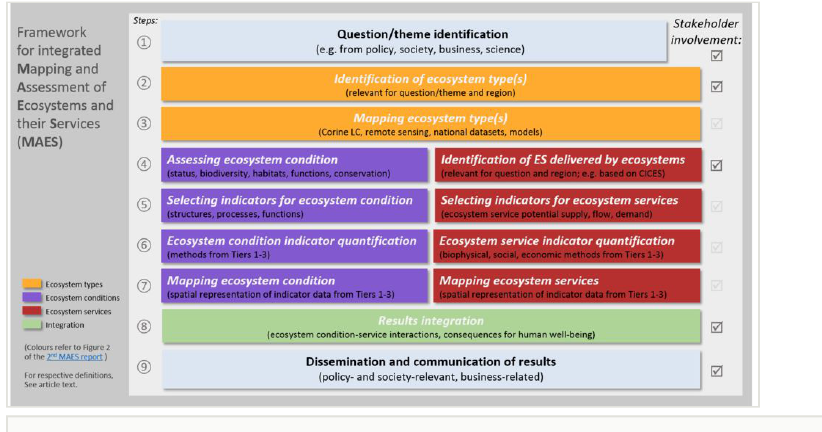
Figure 1. Framework for integrated Mapping and Assessment of Ecosystems and their Services (MAES). Colours and basic structure refer to Figure 2 of the 2nd MAES report (Maes et al. 2014).